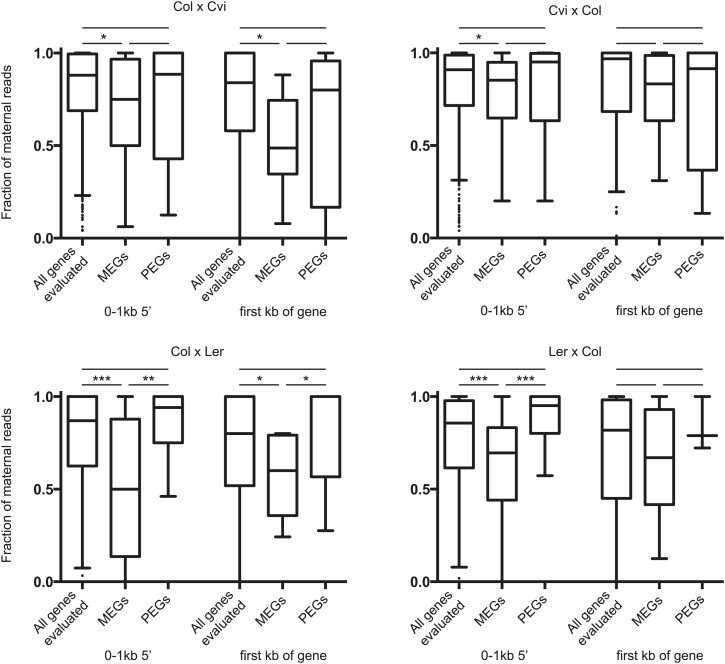
Fraction of maternal small RNAs near the 5’ end of imprinted genes.Boxplots illustrating the fraction of classified 24 nt sRNA reads identified as derived from the maternally inherited genome for the set of all genes that were analyzed for imprinting, the union of all identified MEGs, and the union of all identified PEGs (Figure 1B). Windows had to exceed a threshold of five classified reads (i.e., reads that could be assigned to the maternal or paternal genome based on SNPs) to be included in the analysis. p-values were calculated using the Wilcoxon-Mann-Whitney test. *p<0.05; **p<0.01; ***p<0.001.